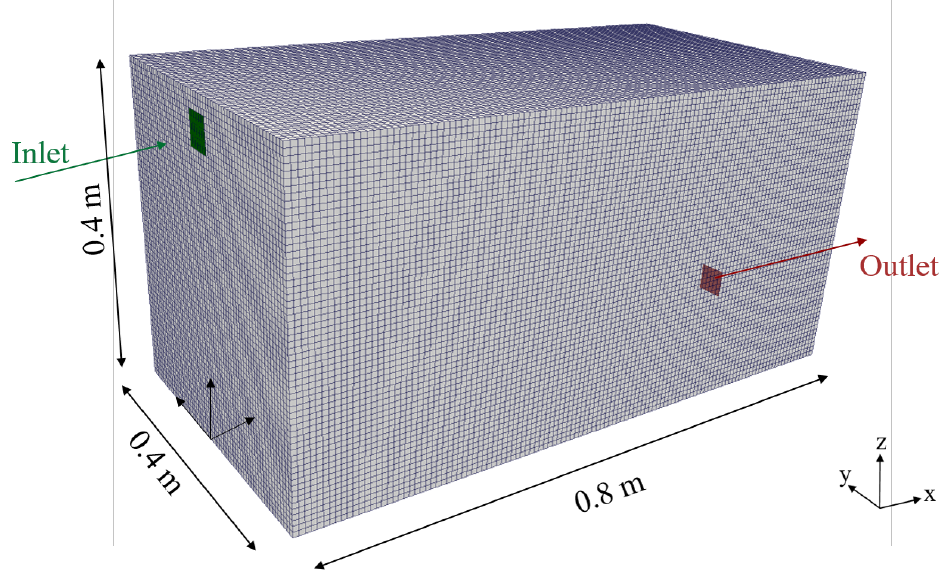
Figure 5. Geometry and mesh for particle phase